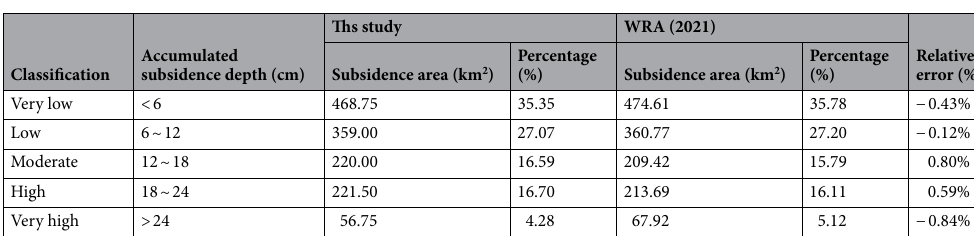
Table 3. Land subsidence prediction